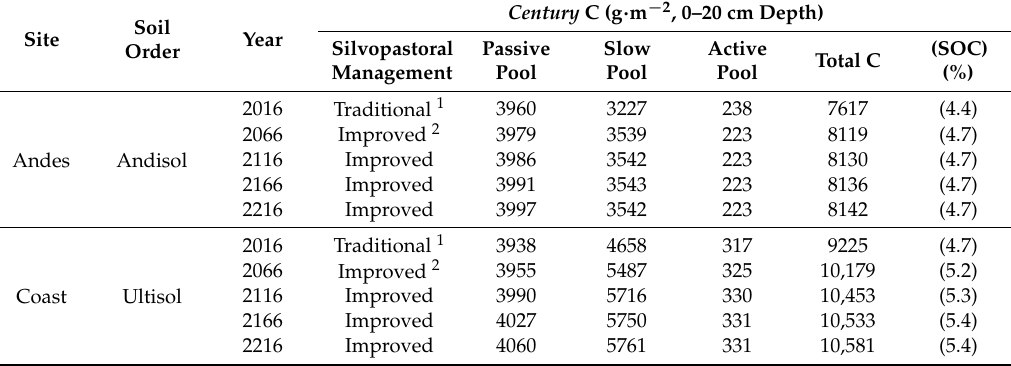
Table 5. Projections of soil organic carbon (C) stocks in soil (0–20 cm depth) in degraded Nothofagus forests of the Santa Bárbara soil (medial, amorphic, mesic Typic Hapludands), and Nahuelbuta soil (very fine, mixed, semiactive, mesic Typic Paleudults) of the Andes and Coastal mountain ranges, respectively, of south central Chile as simulated using the Century model. Measurements were taken in September